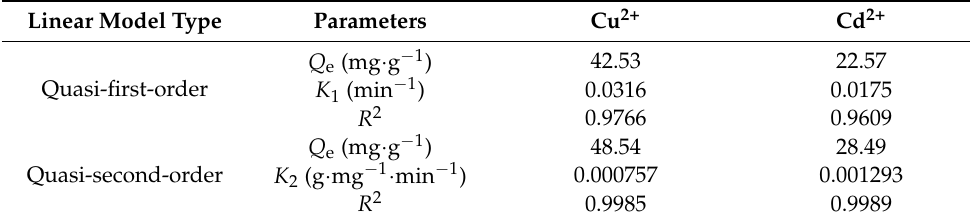
Table 3. Fitting parameters of adsorption kinetics of BHW adsorption of Cd 2+ and Cu 2+ .